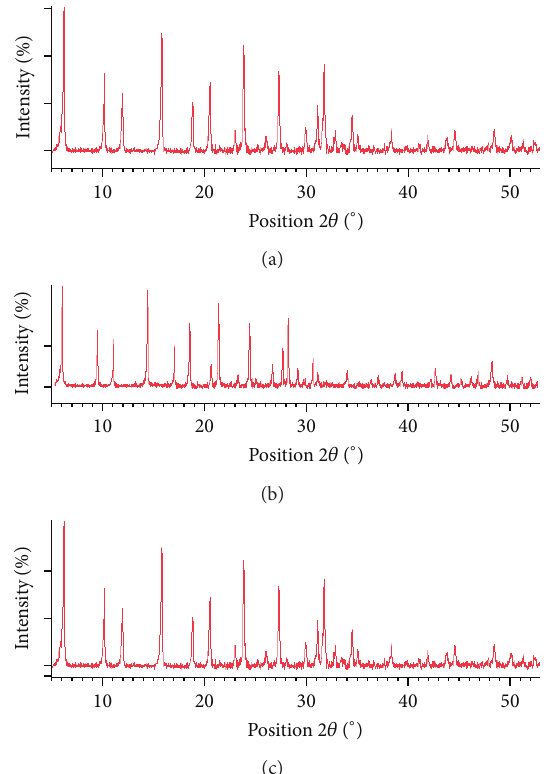
Figure 2: XRD patterns of (a) Fe(II)-Y zeolite, (b) Fe(III)-Y zeolite, and (c) zeolite.